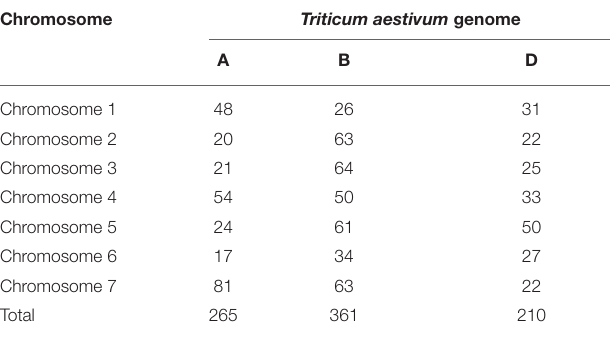
TABLE 3 | Number of markers grouped by each wheat chromosome and genome in the RIL mapping population. Chromosome Triticum aestivum genome